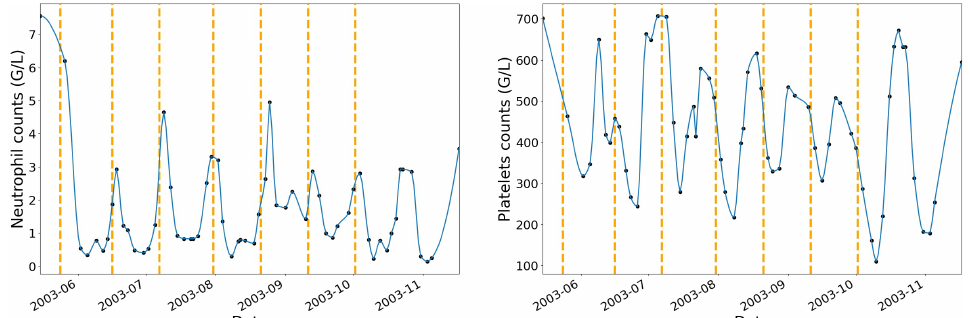
Figure 2. Example of the piecewise cubic hermite interpolating polynomial function applied on one patient’s neutrophils and platelets data. The blue curve shows the interpolation that was used to extract additional blood cell counts when no blood tests have been performed. Black dots represent the observed data. Vertical dashed lines show the beginning dates of each treatment cycle.